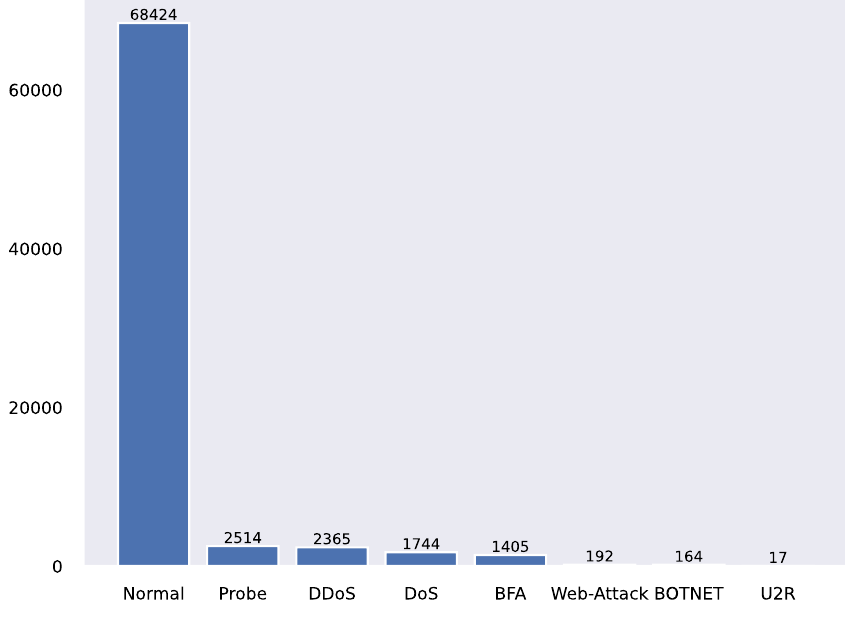
Figure 4. Label distribution in the